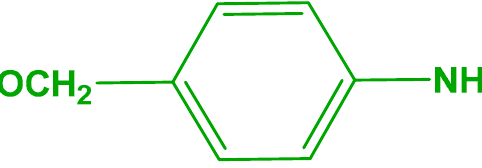
Scheme 2. Structure of 4-Aminobenzyl alcohol.